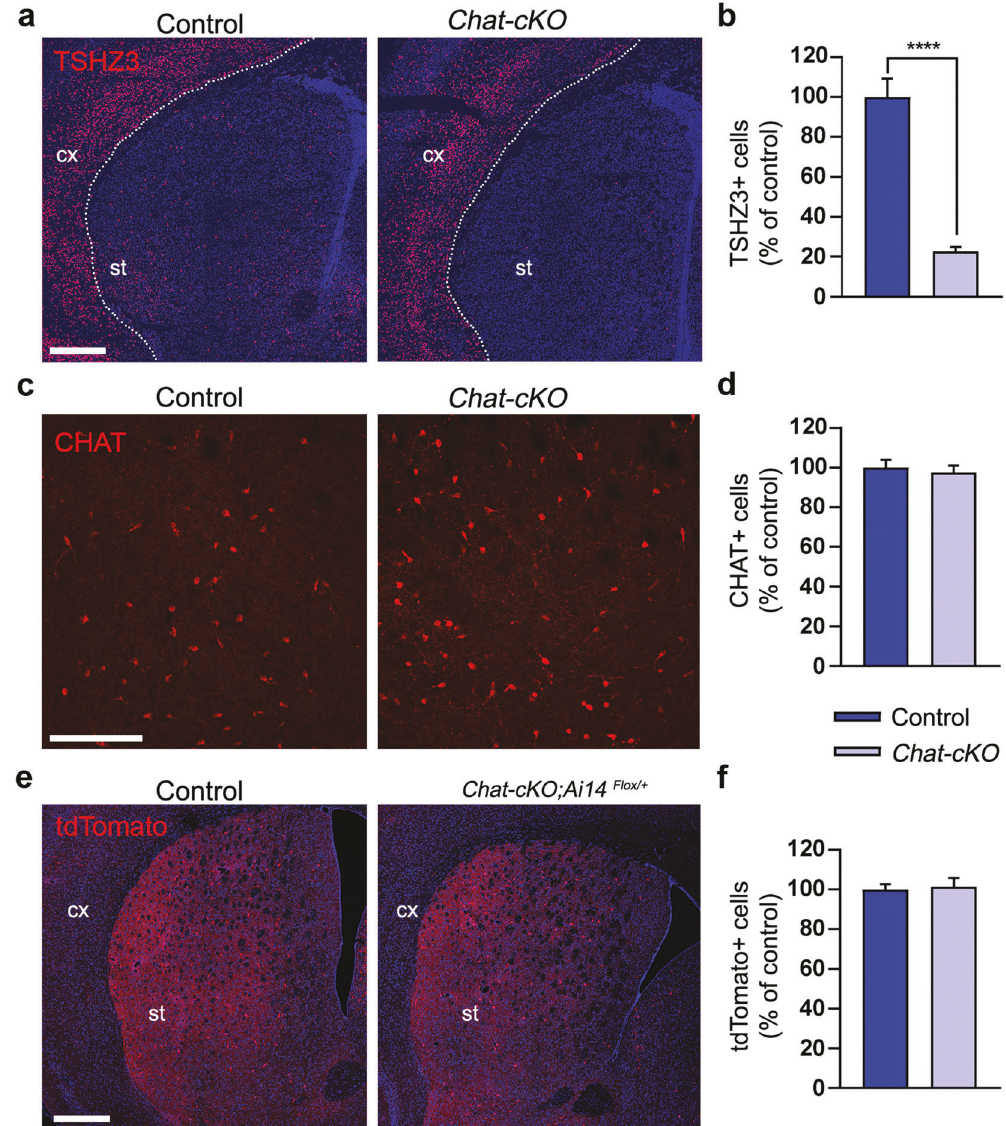
Fig. 3 Conditional Tshz3 deletion in cholinergic neurons. a Coronal brain sections from control and Chat-cKO mice immunostained for TSHZ3 and counterstained with DAPI. Scale bar 500 µm. b Number of TSHZ3-positive cells in the striatum of control and Chat-cKO mice (15 sections from 3 control mice; 11 sections from 3 Chat-cKO mice; **** P < 0.0001, Student ’ s t test). c Coronal brain sections from control and Chat-cKO mice stained for CHAT. Scale bar 200 µm. d Number of CHAT-positive SCINs in the striatum of control and Chat-cKO mice (40 sections from 9 control mice; 53 sections from 11 Chat-cKO mice; P = 0.6373, Student ’ s t test). e Representative images showing tdTomato fl uorescence detection (red) in SCINs of Chat-Cre;Ai14 Flox/ + control and Chat-cKO;Ai14 Flox/ + mutant mice (coronal sections). cx, cerebral cortex; st, striatum. Nuclei are counterstained with DAPI. Scale bar 500 µm. f Number of tdTomato-positive cells in the striatum of Chat-Cre;Ai14 Flox/ + control and Chat-cKO;Ai14 Flox/ + mutant mice (14 sections from 3 control mice; 12 sections from 3 Chat-cKO;Ai14 Flox/ + mice; P = 0.7773, Student ’ s t test). Da t a in ( b ), ( d ), and ( f ) are expressed as percent of mean control value and represented as means +